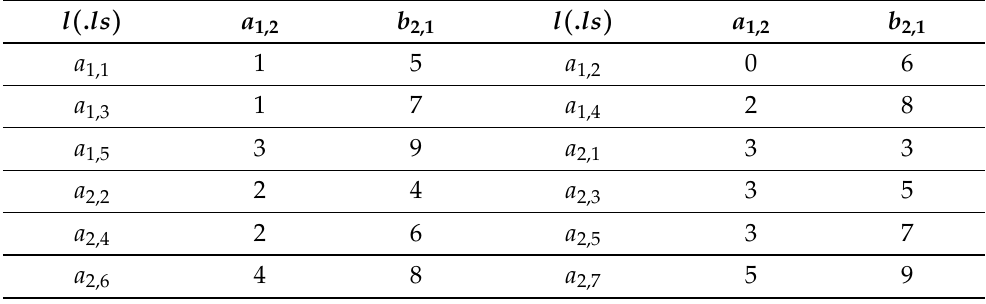
Table 3. Locations of the nodes of GHCN ( 2,3,2 ) .